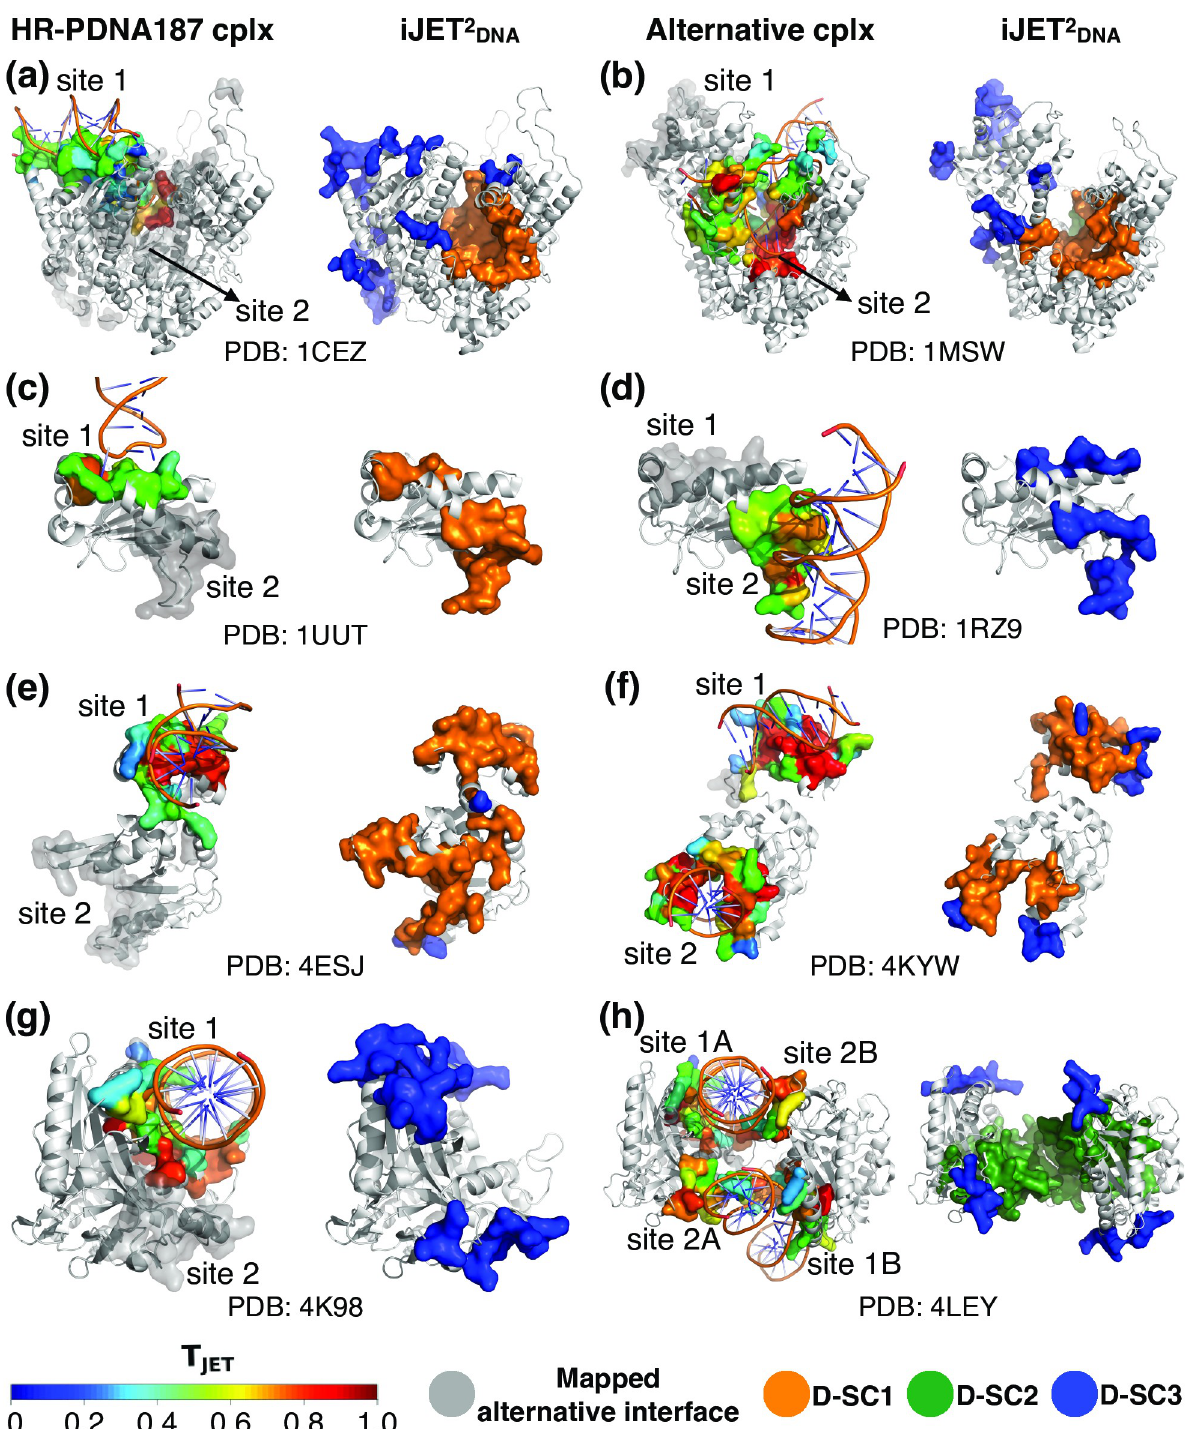
Fig 5. Prediction of multiple DNA-binding sites by iJET 2 . For each protein (each row), the experimental complex present in HR-PDNA187 and DNA another experimental complex displaying a distinct DNA-binding site are shown on the first and third columns, respectively. For each structure, the ‘main’ DNA-binding site is colored according to T JET values and the site coming from the other structure is mapped and displayed in transparent grey. The iJET 2 predictions computed on each experimental structure are displayed on the second and fourth columns, respectively, and colored DNA according to the scoring scheme. (a-b) RNA polymerase from bacteriophage T7 (PDB: 1CEZ and 1MSW); (c-d) N-terminal domain of the adeno- associated virus replication protein (1UUT and 1RZ9); (e-f) R.DpnI modification-dependent restriction endonuclease (4ESJ and 4KYW); (g-h) Cyclic